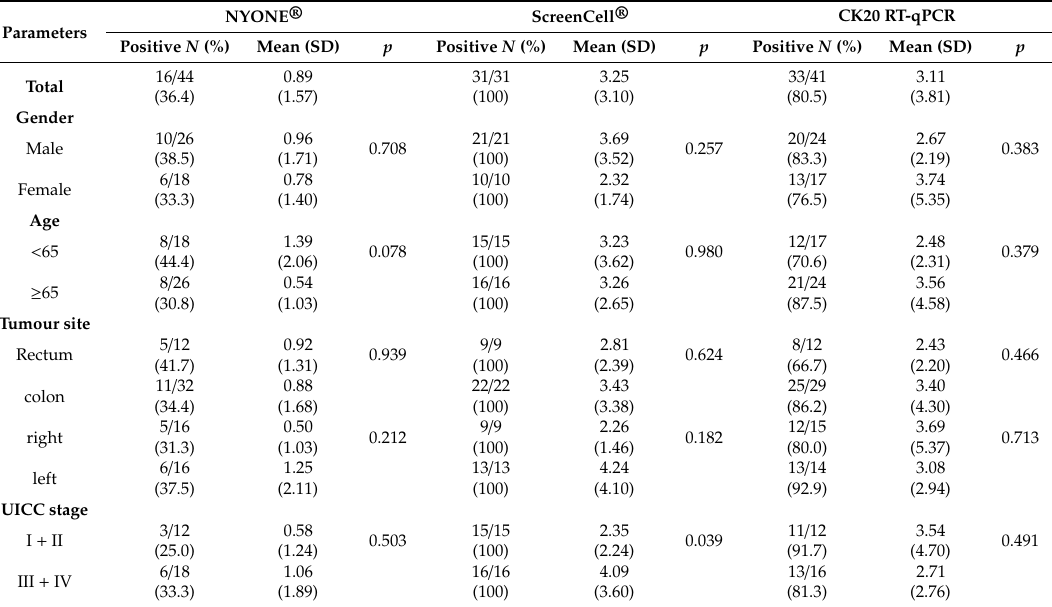
6 / 18 (33.3) Statistical analysis was performed using an unpaired t -test for parametric and a Mann-Whitney U-test for non-parametric data. All p -values in bold are regarded as statistically significant. Abbreviations: UICC—Union internationale contre le cancer; SD—standard